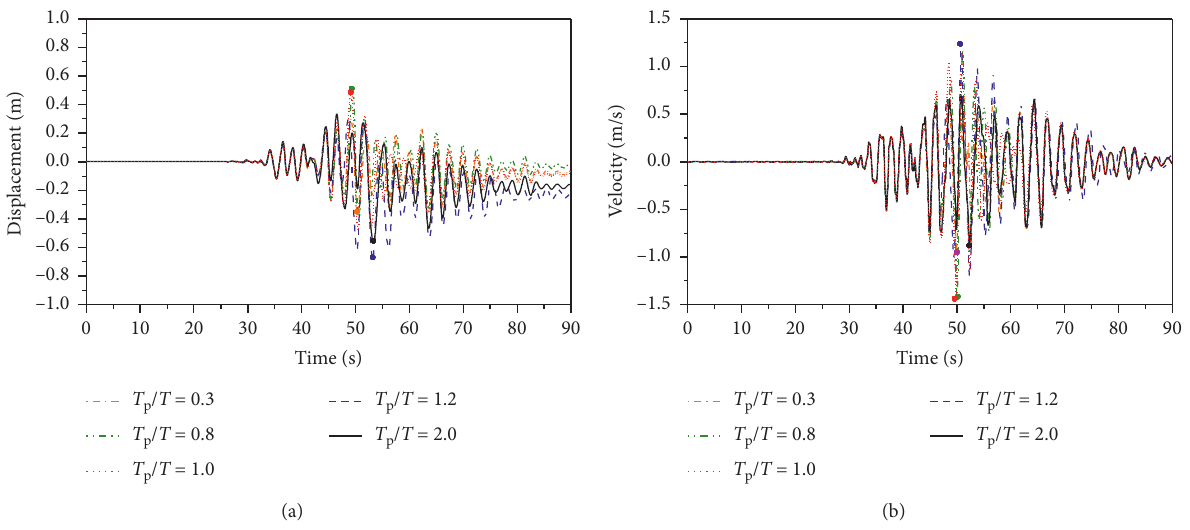
Figure 18: Seismic response of the top storey of the building-BRB system. (a) Displacement response. (b) Velocity response. Fundamental mode